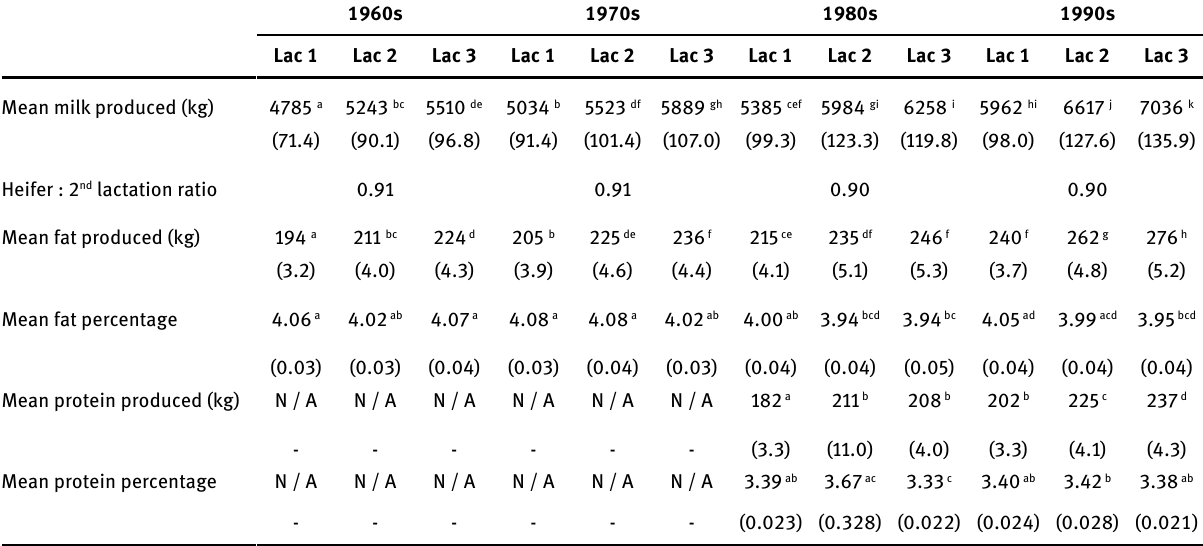
Table 1: Values shown are for the means for the first three lactations for each of the four decades examined and include total milk produc- tion (kg) as well as percentage protein (only available for 1980s and 1990s) and percentage fat as well the mean proportion of milk produc- tion by each heifer during her first lactation relative to her second lactation. Values shown in parenthesis are standard error of the mean (SEM) values. Samples within any row which are not significantly different (i.e. P>0.05) share the same superscript. N/A denotes values were not available